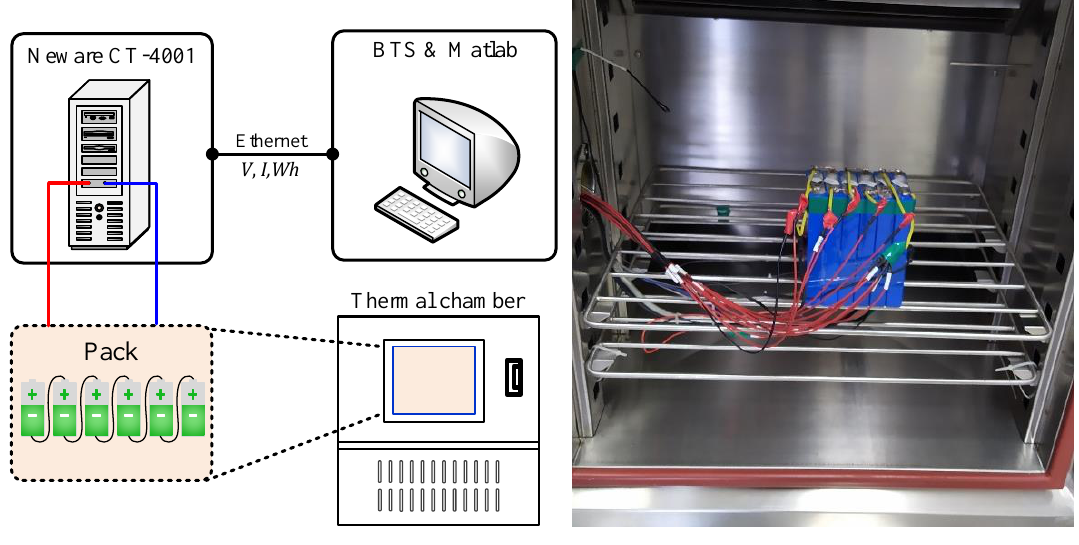
Figure 1. Experimental platform.